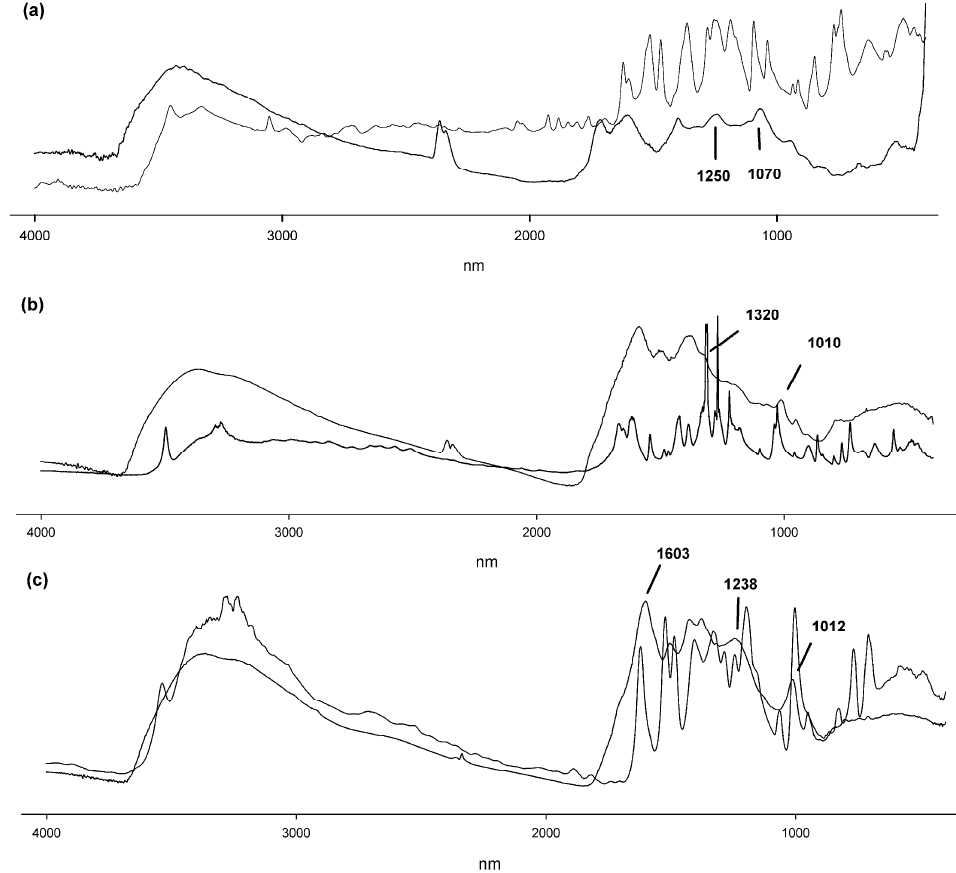
Figure 3. FT-IR spectra of the synthesized products and the respective monomers, ( a ) catechol; ( b ) gallic acid; ( c ) pyrogallol. Grey lines represent the monomer spectra, black lines represent the polymers. Characteristic peaks and shoulders, as referred to in the text, are indicated.